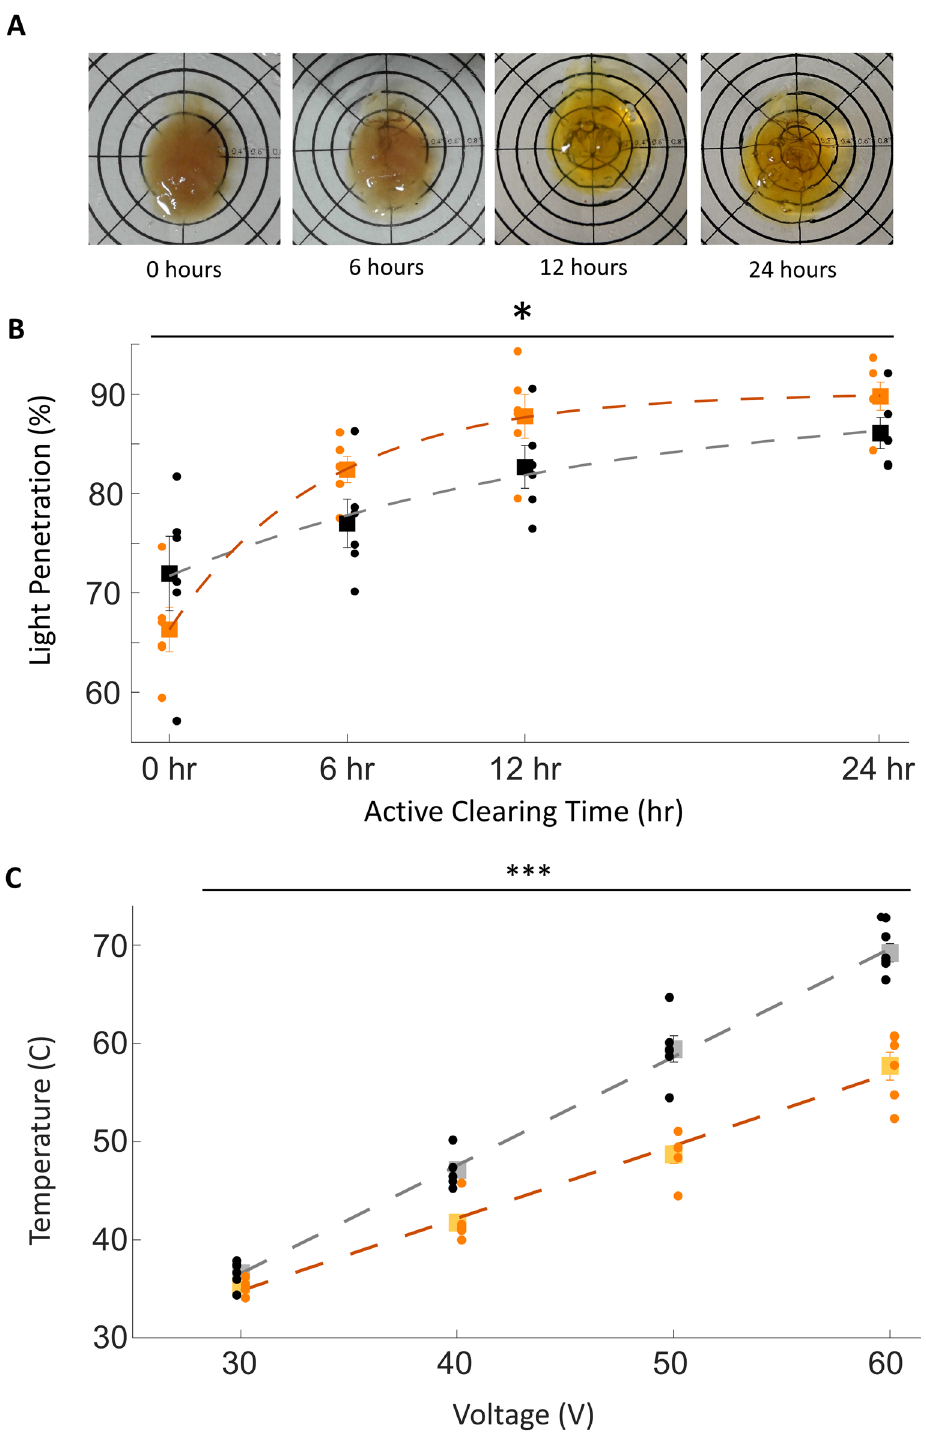
Figure 2. MHD-accelerated clearing of the intact mouse brain. ( A ) Representative examples of intact cleared brains actively cleared with MHD for 0, 6, 12, and 24 h and then equilibrated in RI-matching solution (N = 6). ( B ) Measurements of the optical transparency of mouse brains cleared using MHD force (red) or electrical force combined with a pump to circulate buffer solution (black). Transparency was measured as percentage wide-spectrum light penetration through the tissue. Both MHD and electric only data were fit to saturating exponentials (MHD: y = 89.9 − 18.2 ∗ e − 0.07 x ; Electric-only: y = 90.1 − 23.8 ∗ e − 0.19 x ). A significant interaction between electrical and MHD clearing over time is denoted by an asterisk F{2,3} = 3.24, p = 0.03. ( C ) Average peak temperature of tissue actively cleared with MHD (orange) was lower than electric-only (black) at voltages ranging from 30 to 60 V (two-way ANOVA F{1,3} = 119, p < 0.0001; linear fit for electric-only y = 1.1 x + 3.6 ; linear fit for MHD: y = 0.7 x + 12.7